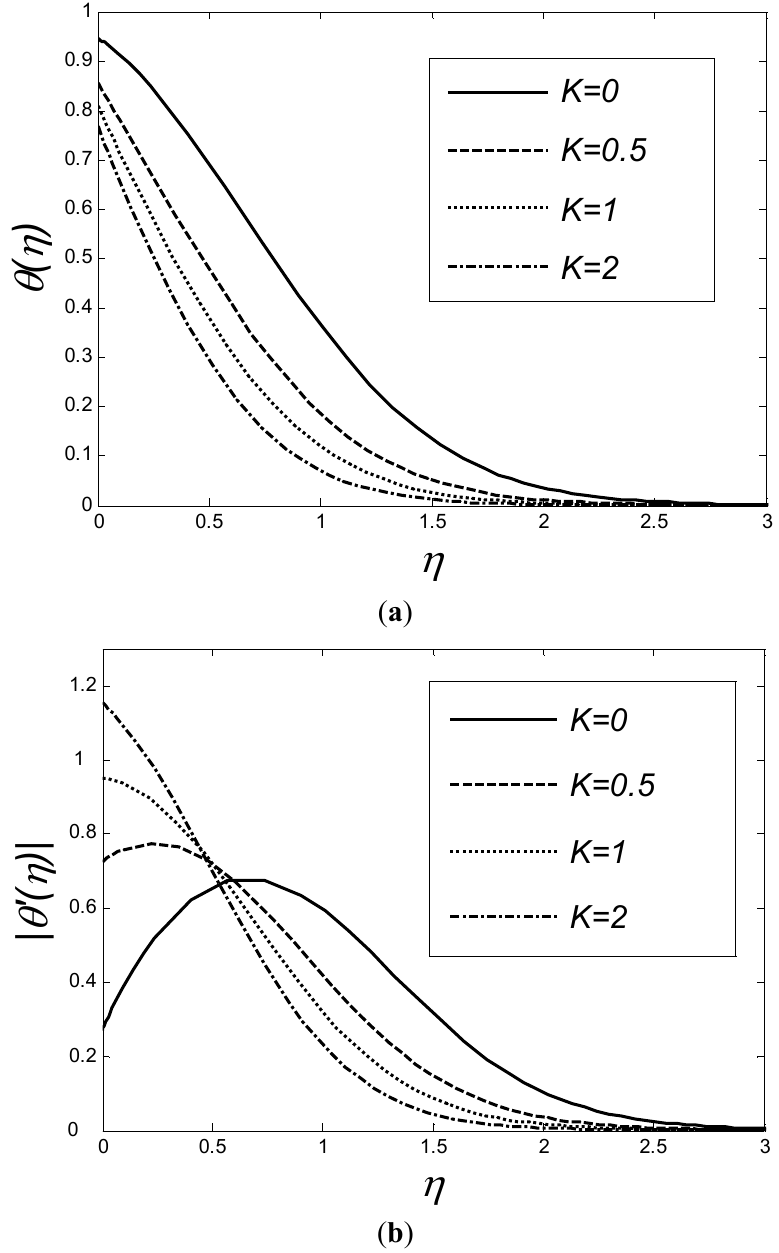
= 0.2, a = 5 and M = w